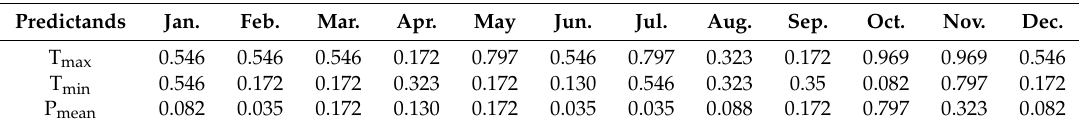
Table 2. p -Values of Kolmogorov-Smirnov two-sample test (KS Test) for observations and downscaled predictands (Historical).